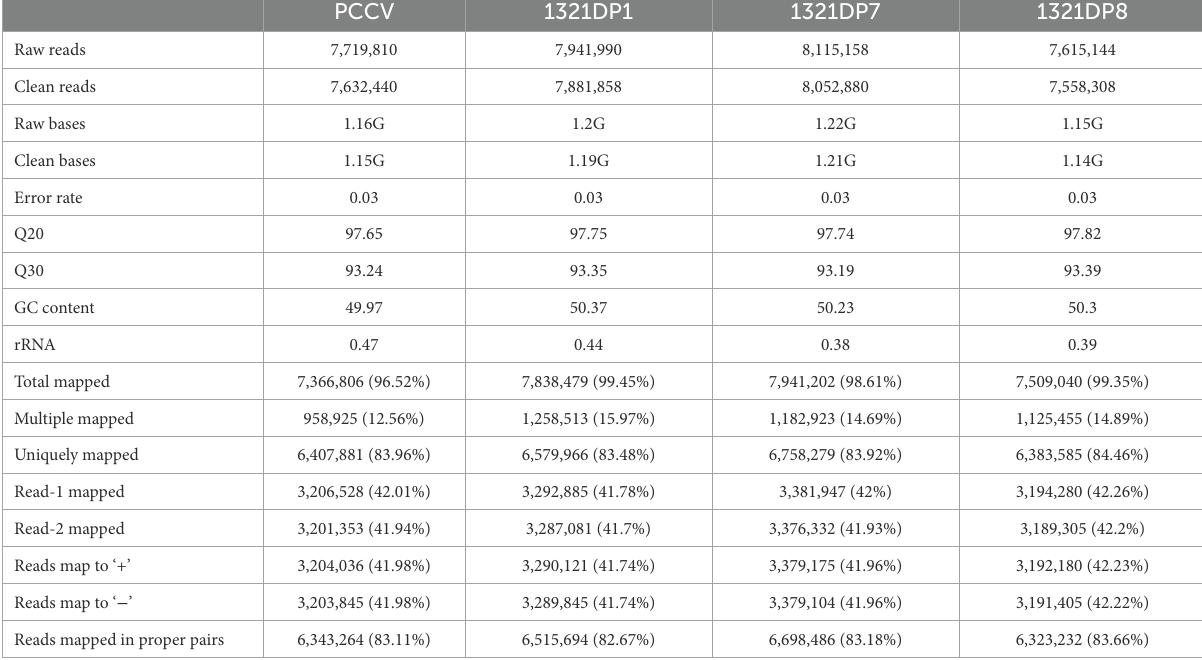
TABLE 3 Statistics of RNA-seq